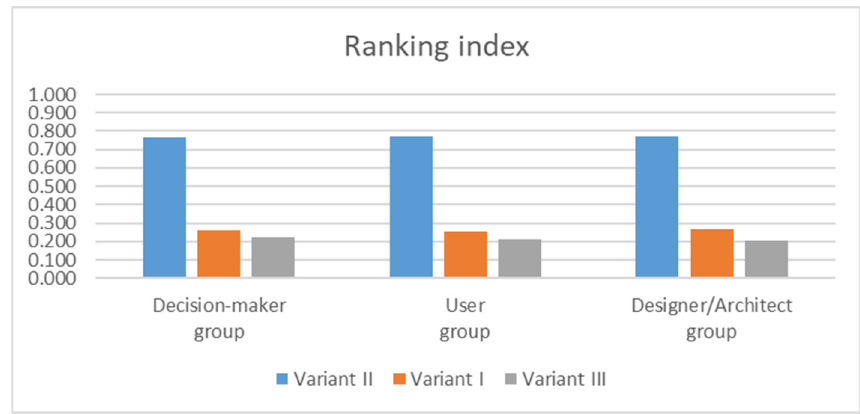
Figure 1. Final ranking of variants. Table 15. Final ranking of variants—normalized.